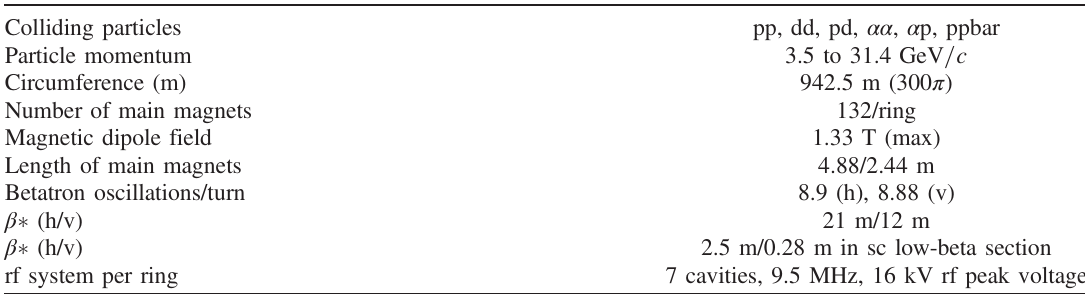
TABLE I. Basic parameters of the